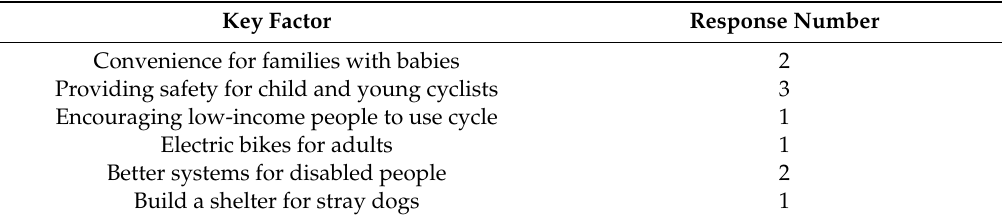
Table A9. Special